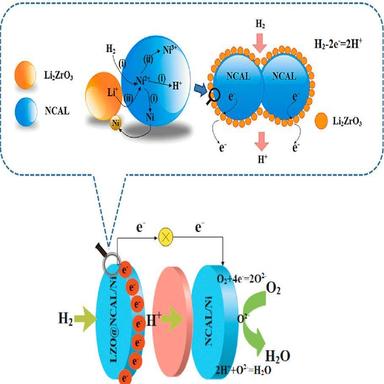
Mechanism of action of 1 wt % LZO@NCAL. (i) reduction of Ni2+ to Ni in H2 atmosphere; (ii) Li+ from LZO interacts with the free Ni2+ in NCAL.